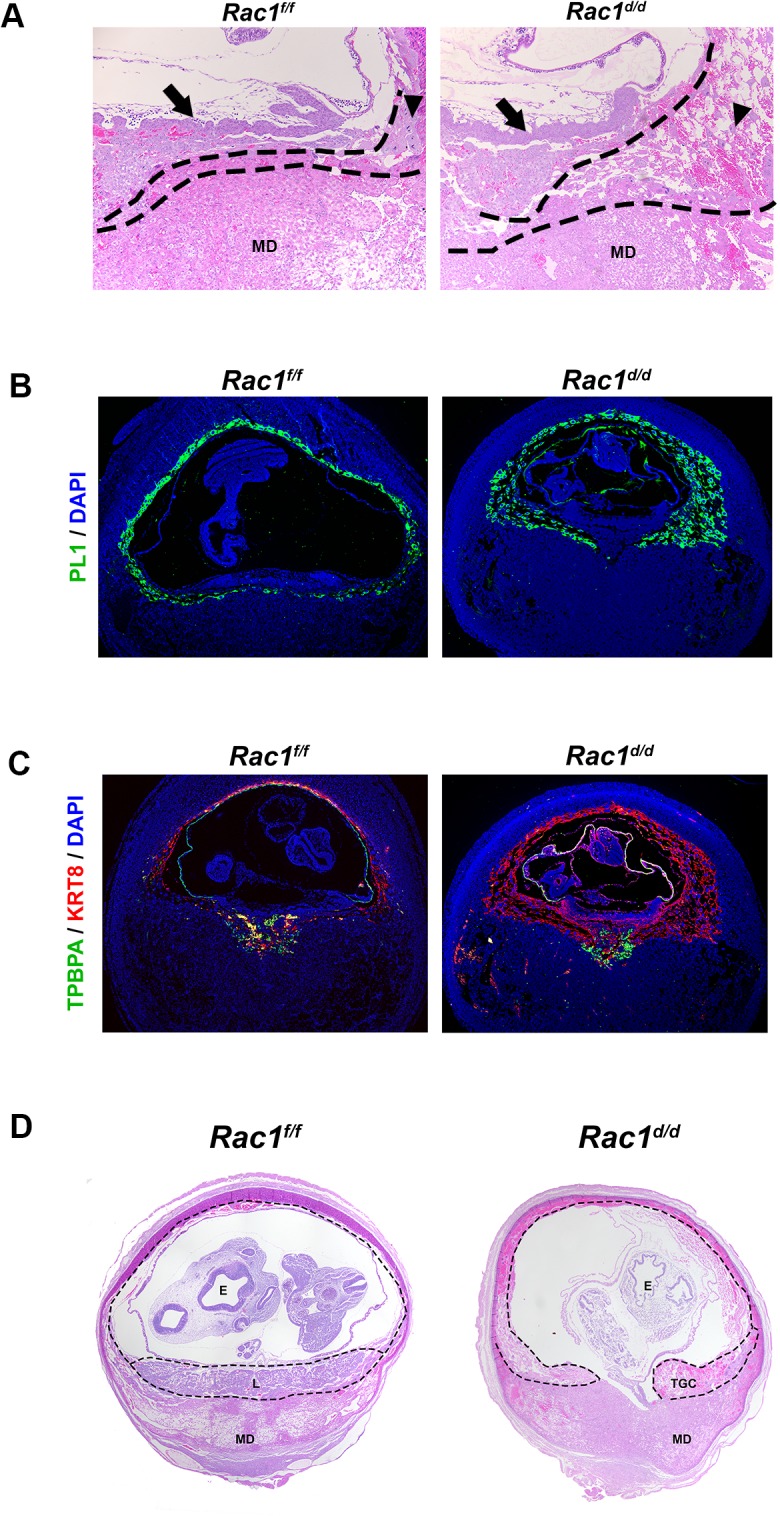
Abnormal trophoblast proliferation, differentiation and disorganized placentation in Rac1 conditional-knockout mouse.(A & B) Increased population of trophoblast giant cells (TGCs) in the placenta of Rac1d/d uteri. (A) H and E staining of uterine sections from Rac1
f/f and Rac1
d/d mice on day 10 of pregnancy. TGC and MD indicate trophoblast giant cells and mesometrial decidua, respectively. TGCs are demarcated by dashed lines. Arrows indicate chorionic plate and arrow-heads indicate TGCs. (B) Uterine sections from Rac1
f/f and Rac1
d/d mice on day 10 of pregnancy were subjected to IF using PL1. (C) Uterine sections from Rac1
f/f and Rac1
d/d mice on day 10 of pregnancy were subjected to IF using TPBPA and KRT8 antibodies. (D) H and E staining of uterine sections from Rac1
f/f and Rac1
d/d mice on day 12 of pregnancy. TGC, MD and E indicate trophoblast giant cells, mesometrial decidua, and embryo, respectively.